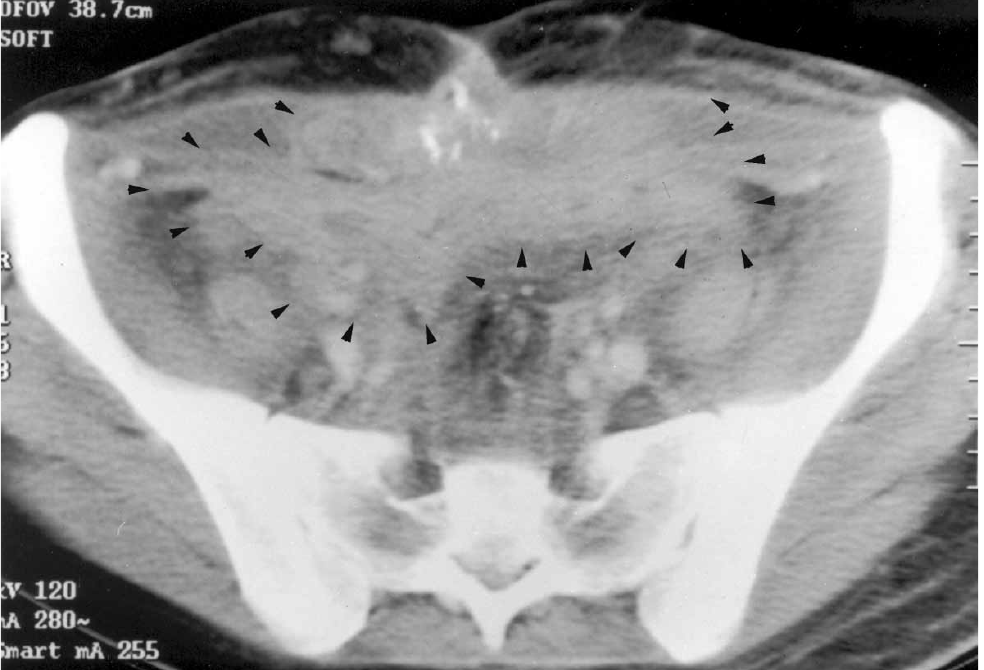
Fig. 5. Baseline CT taken in August 1999 showing dense fibrosis within the abdomen. The main tumour plaque has been outlined by arrowheads. There are no visible gas-filled bowel loops due to persistent small bowel obstruction and physical compression of the bowel by tumour.